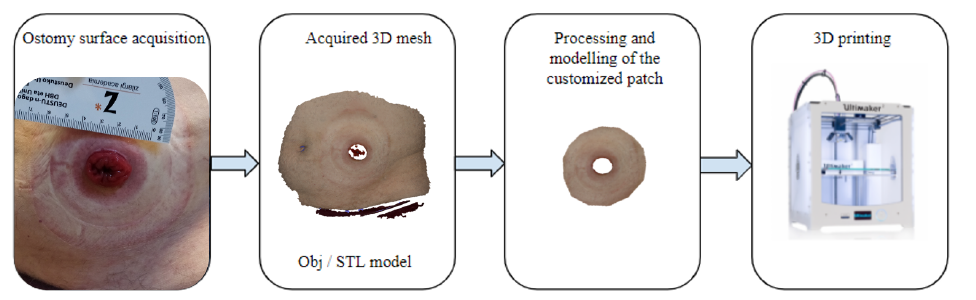
Figure 1. Pipeline illustrating the main steps for the creation of the customized ostomy